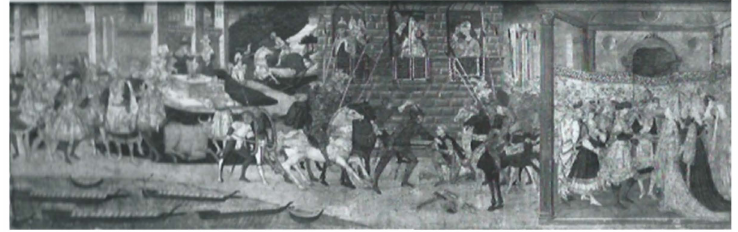
Figure 5. Apollonio di Giovanni. Death of Camilla and the Wedding of Aeneas and Lavinia . c.1460. Ecouen: Mus é e de la Renaissance.